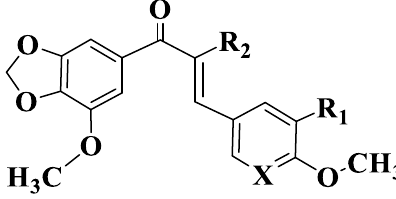
Figure 10. General structure of chalcones 179 – 187 .